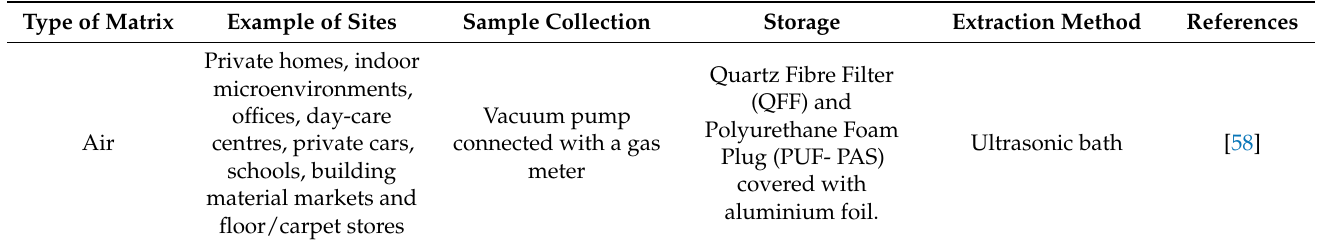
Table 4. Table showing the list of some matrices and how they are sampled, stored and